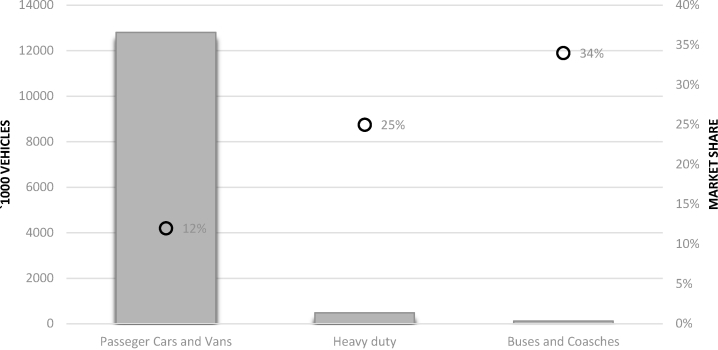
Elaboration from NGVA’s gas vehicle roadmap towards 2030 (NGVA Europe, 2018).